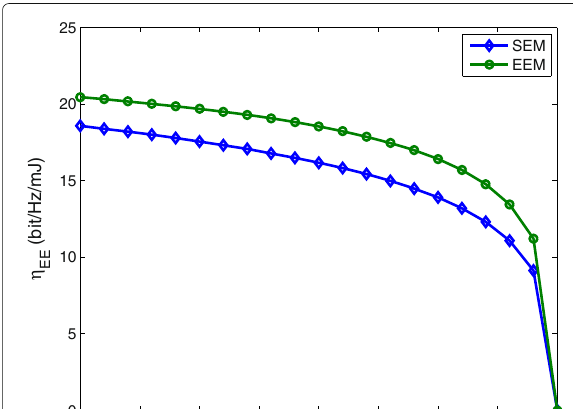
Fig. 5 Energy efficiency comparison